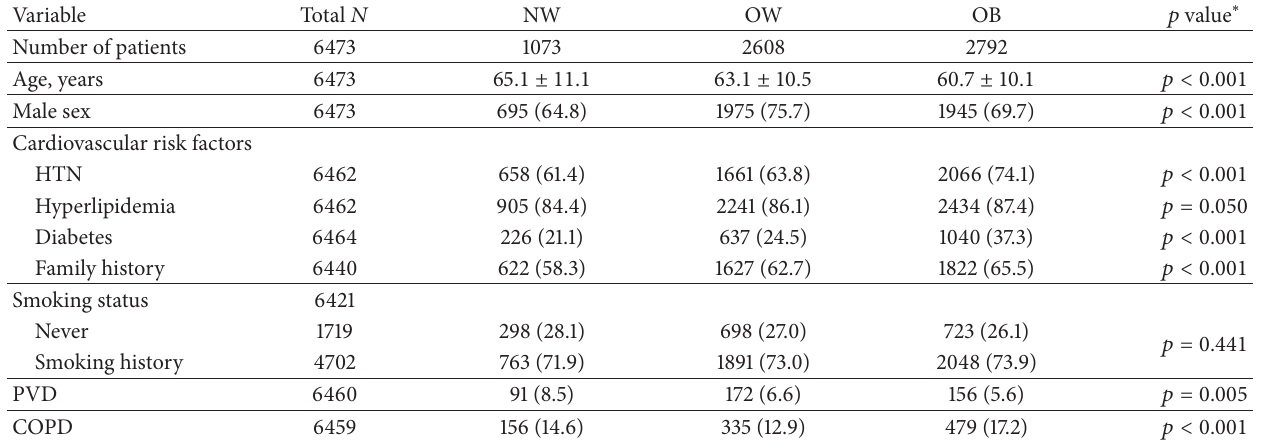
Table 1: Baseline characteristics of patients according to categories of BMI.